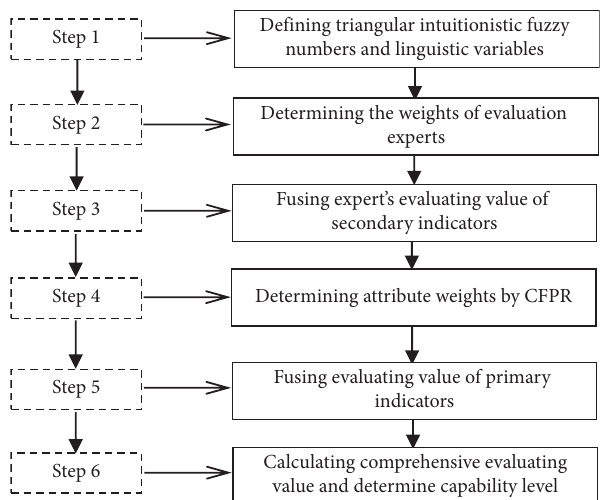
Figure 2: Evaluation process of BTIC of petroleum equipment manufacturing